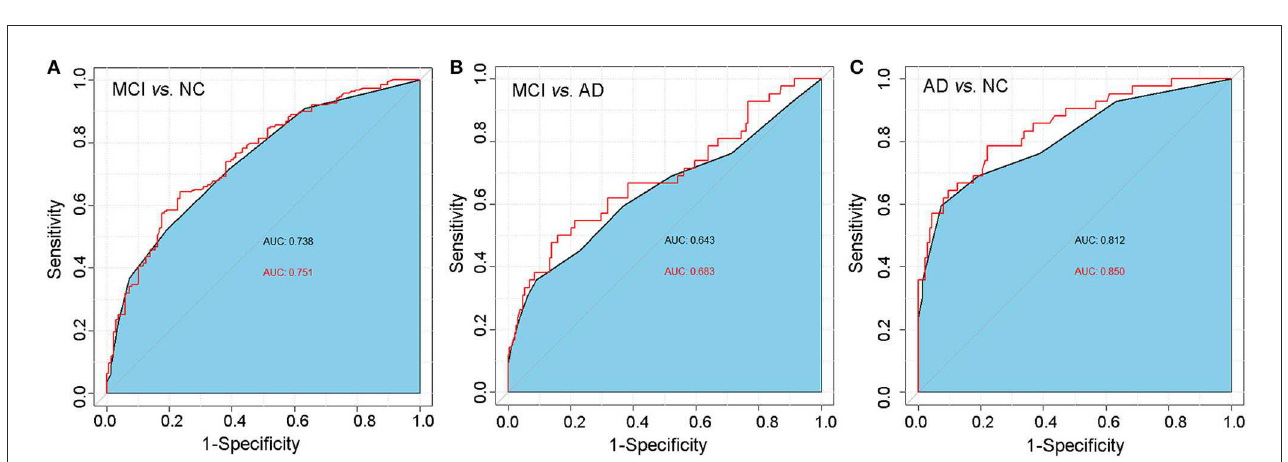
FIGURE4 ROC analysis of the predictive value of the CSIT score in distinguishing MCI or AD from normal-aging adults. (A) MCI vs. NC; (B) AD vs. NC; (C) MCI vs.